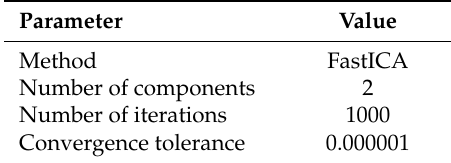
Figure 8. Measuring chain of hybrid LMS and ICA filtrations. Table 5. ICA function block parameter settings.